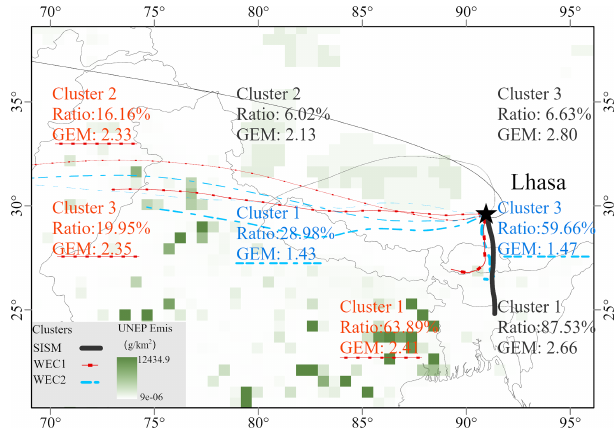
Figure 5. Clusters of the back trajectory analysis from Lhasa during S-ISM and WEC periods. The thickness of the line represents the ratio of the cluster in the time period, and the background is the global Hg emission inventory developed by UNEP